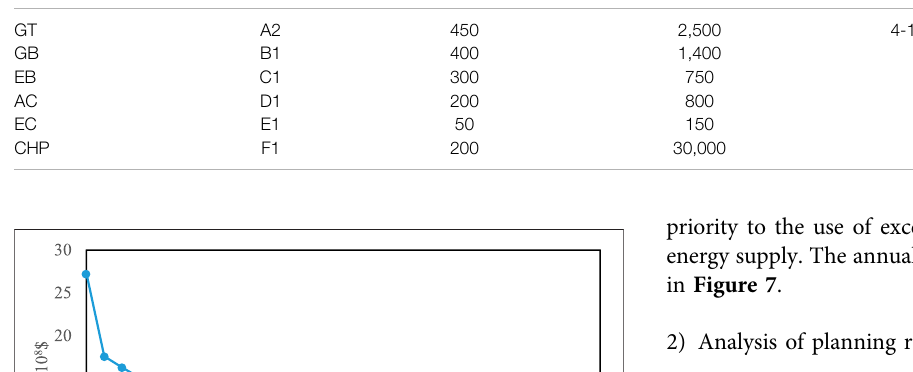
TABLE 2 | EH planning results under S1. Equipment type